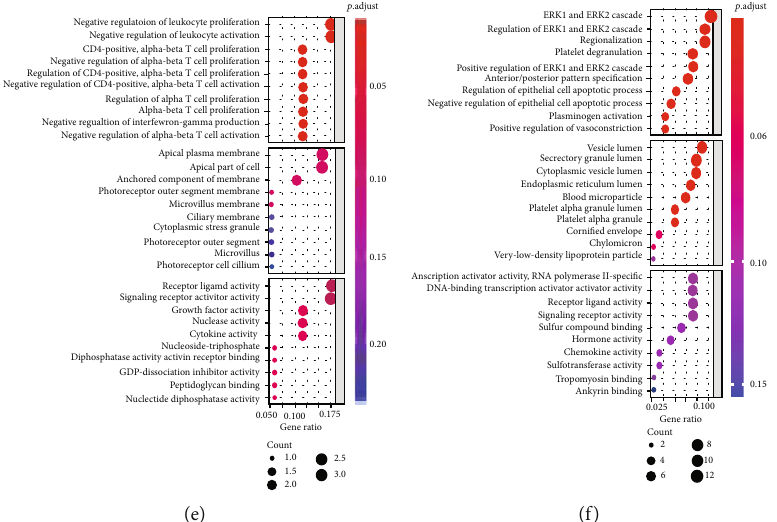
Figure 4: Di ff erential expression of immune signatures among three m6A clusters. (a) Heat map depicting the expression pro fi le of 21 m6A regulators. (b) A boxplot of relative immune signatures among three m6A clusters. (c) Di ff erential expression of immunomodulatory molecule expression among tumor m6A clusters. (d) A volcano plot of di ff erential expression gene analysis among three m6A clusters. (e) Gene Ontology (GO) enrichment analysis of upregulated gene sets among m6A clusters. (f) GO enrichment analysis of downregulated gene sets among m6A clusters.